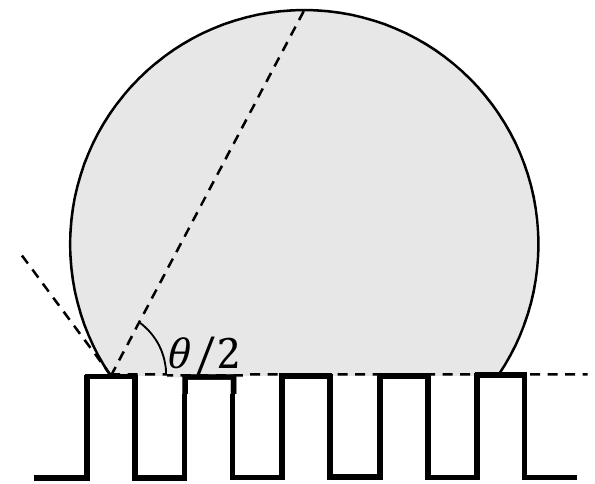
Figure 3. Schematic diagram of contact angle θ measurement on nanostructures by half angle method.